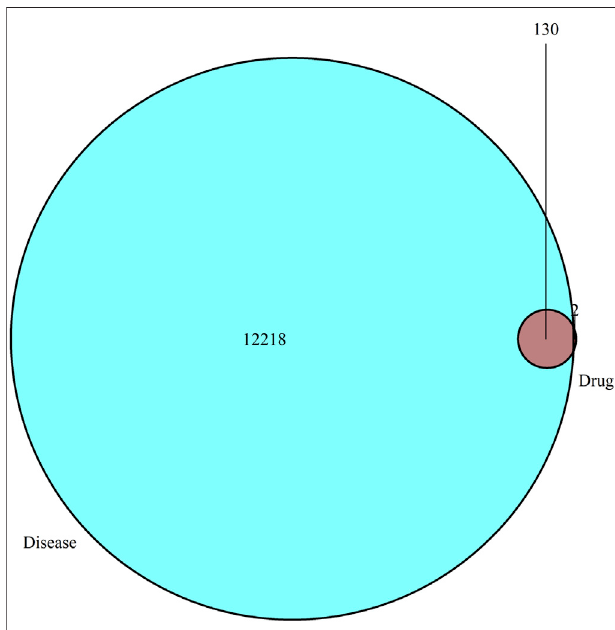
FIGURE 1 | Venn diagram summarizing the intersection targets of CCYSD and CKD.